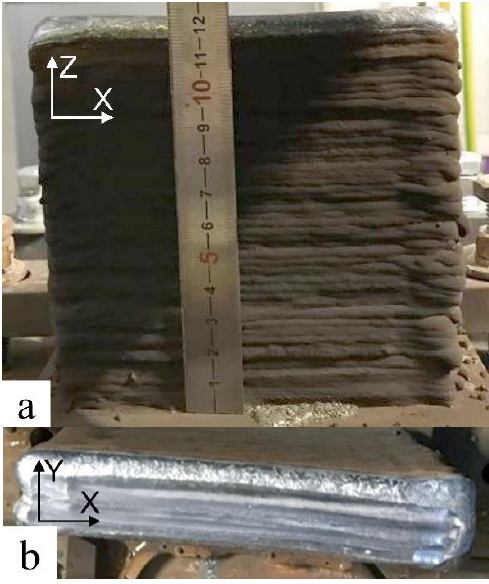
Figure 3. View of the workpiece: ( a ) side view, XZ; ( b ) the view from above XY. Microstructural studies were performed for the polished sections cut out in the trans- verse and longitudinal directions of the deposition welding of the wall workpiece. To re- veal the micr ostructure, Vasiliev’s chemical agent was used to treat the polished sections